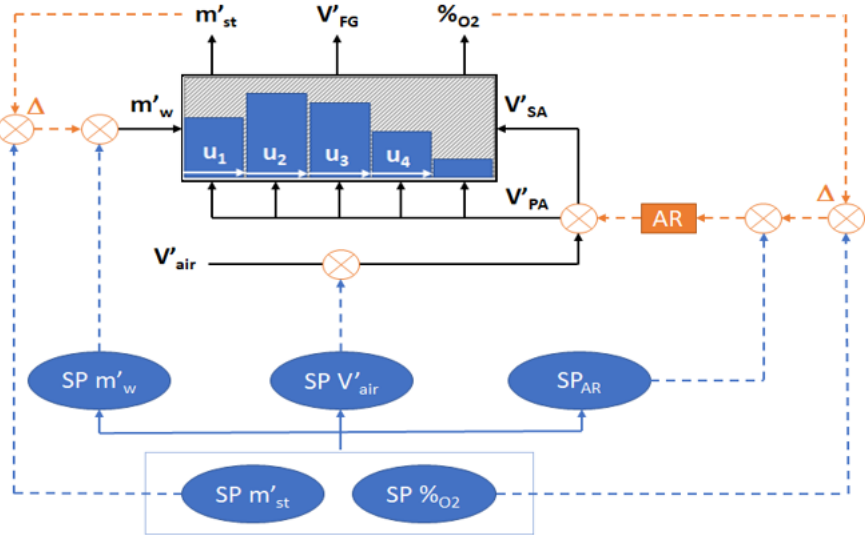
Figure 4. Basic combustion control in WtE plants. Process values used for control: m’ st = steam flow, m’ w = waste throughput, V’ FG = flue gas flow (outlet boiler), V’ air = total combustion air flow, AR = air ratio calculation, V’ PA = primary air flow, V’ SA = secondary air flow, % O2 = O 2 concentration in combustion gas (at outlet boiler). Controllable speeds of grate zones are indicated as u1–u4. Setpoints (SP) imposed or derived are shown in blue. The action of control is represented by symbols and signals in orange. (The control loop associated to grate speed control is not